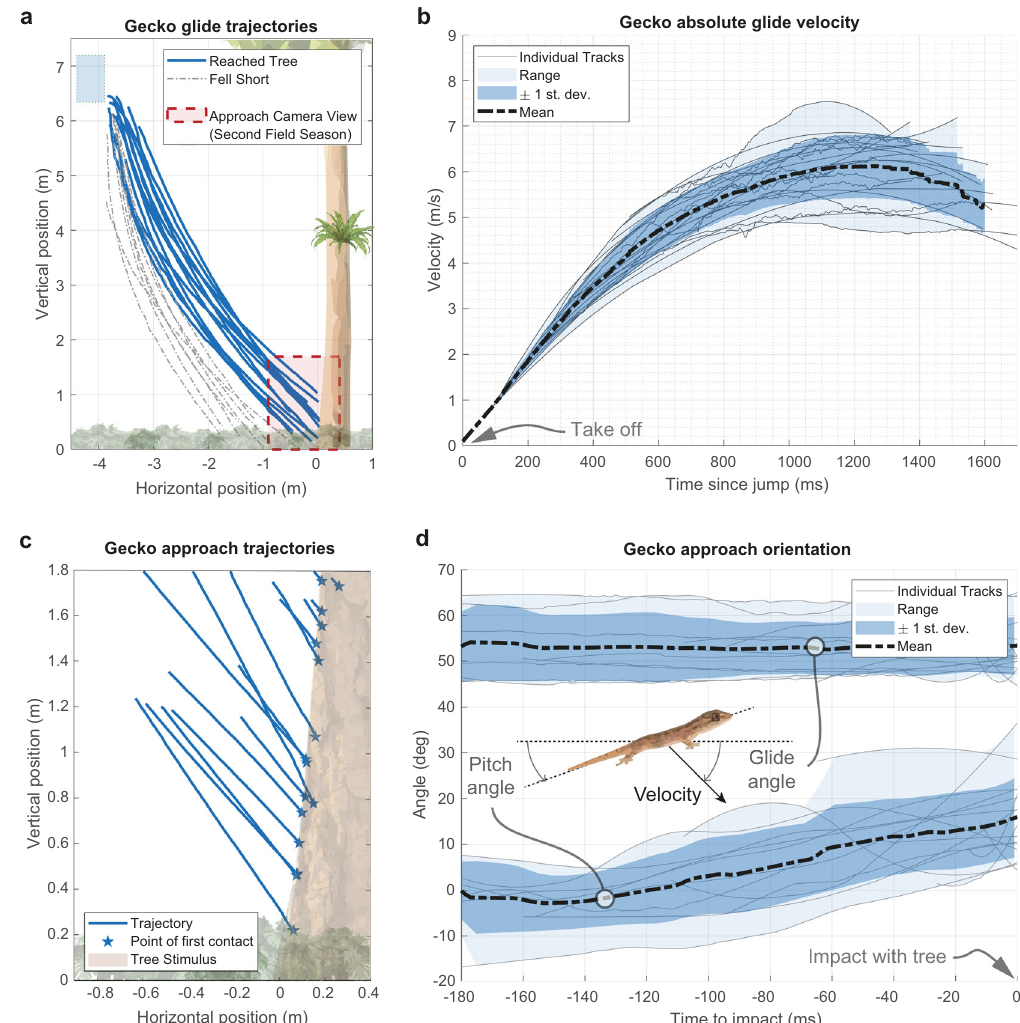
Fig. 1 Gecko gliding behavior in short-range, subcritical glides. a Trajectories of geckos gliding from an elevated platform to the tree stimulus. A total of 21 trials are depicted, of which 13 reach the tree stimulus (62%). b Velocity pro fi le of gecko glides ( n = 21). 4 out of 21 geckos were still accelerating at impact. Mean velocity decreased 6.4 ± 4.9% relative to peak in geckos that were decelerating (17 out of 21 trials). Glides are aligned in time by linearly extrapolating each run to zero since it was not possible to mark the exact point where the gecko became airborne. c Tracked trajectories ( n = 16) from the approach camera view of gecko landing (Supplementary Movie 1, sequence 2). Note that panels c and d show different set of trials and individuals from panels a and b , but using an identical experiment and fi eld site. d Glide angle (velocity vector angle) and body pitch angle relative to the horizontal from approach camera view ( n = 16). Geckos maintained a near constant approach angle, but pitched up their bodies as they traveled, suggesting an attempt to maintain a trajectory by adjusting their